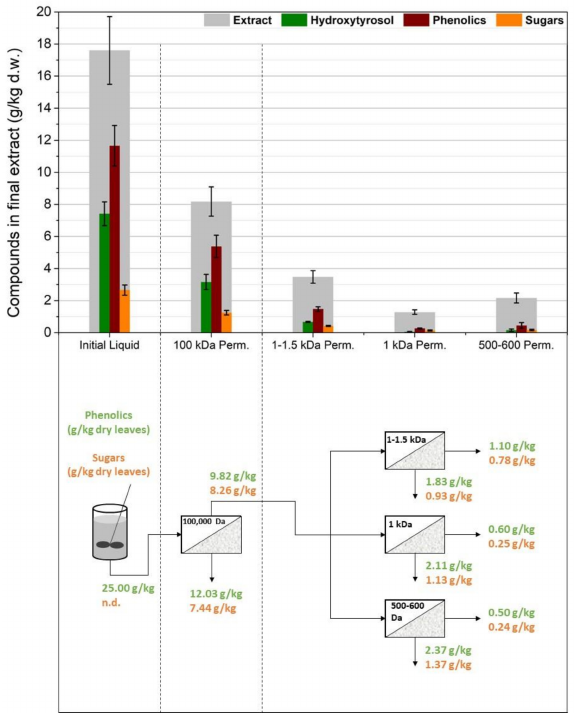
Figure 4. The second membrane treatment scheme: only one ultrafiltration step (US100) was used and the permeate from the 100,000 Da membrane was split into three equal parts and treated using three different nanofiltration membranes (NP010, UA60,